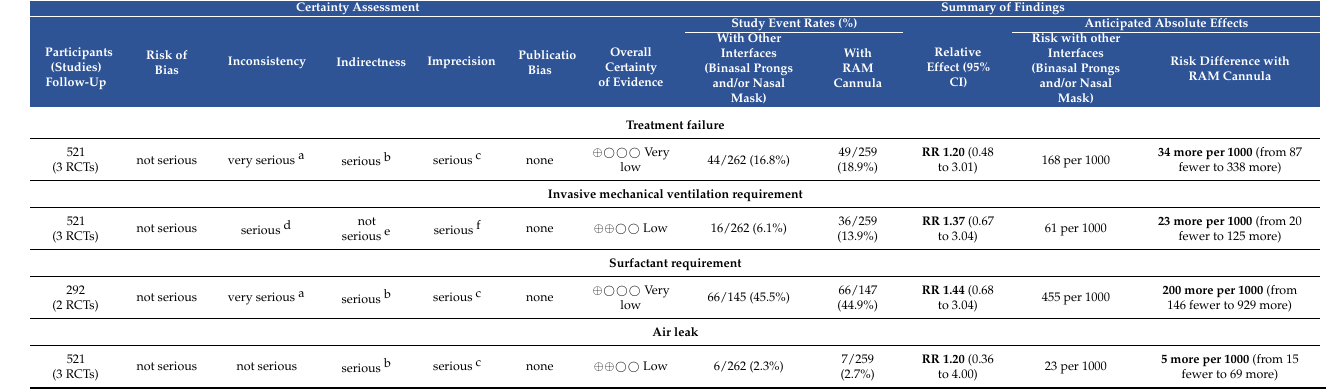
Figure 2. Forest plots depicting the effect estimates for the outcomes: treatment failure, invasive mechanical (IMV) requirement, and surfactant requirement. Table 2. Certainty of evidence assessment for RAM cannula compared to other interfaces (binasal prongs and/or nasal mask) in preterm neonates requiring noninvasive respiratory